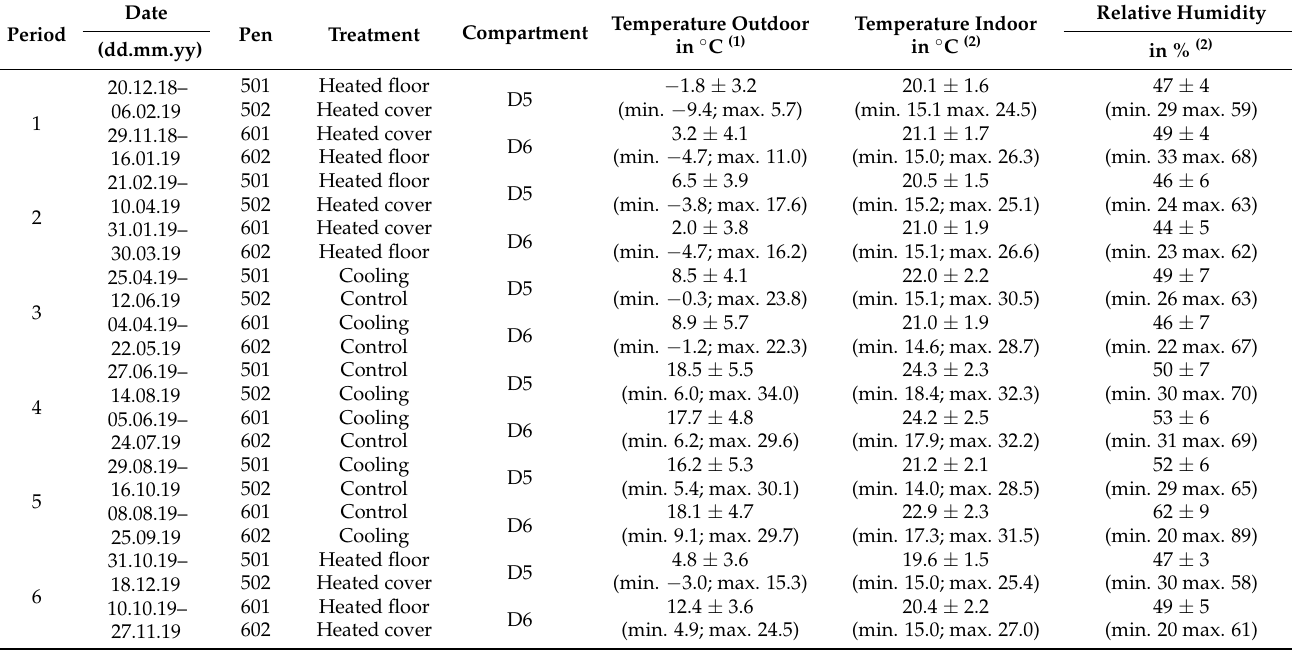
Table 3. Average indoor and outdoor temperatures and relative humidity ( ± standard deviation) for each rearing compart- ment and